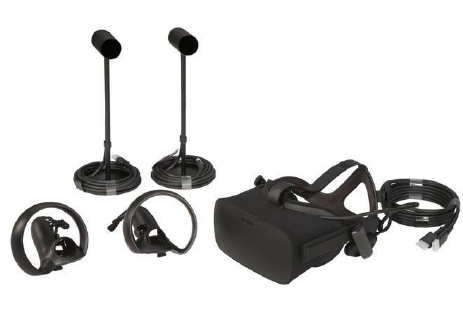
Figure 6. Content of Oculus Rift VR headset.